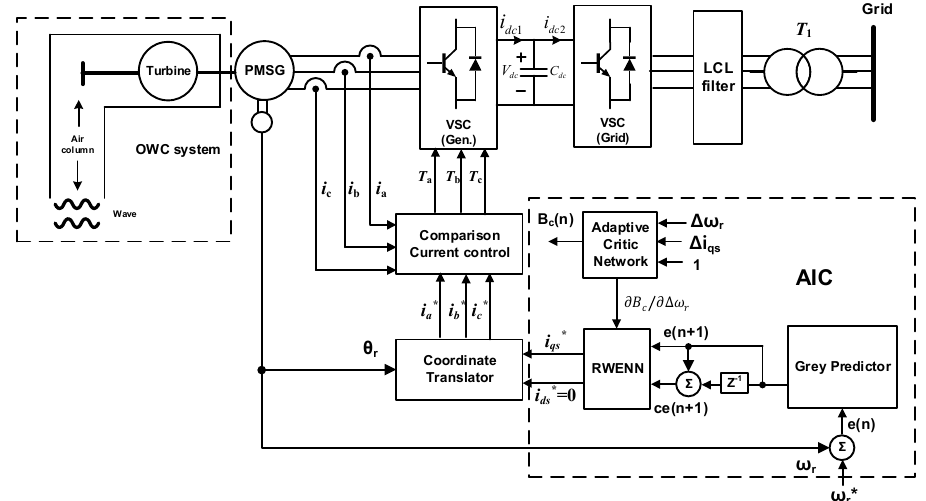
Figure 1. Configuration of the PMSG-based OWC system connected to the power grid.